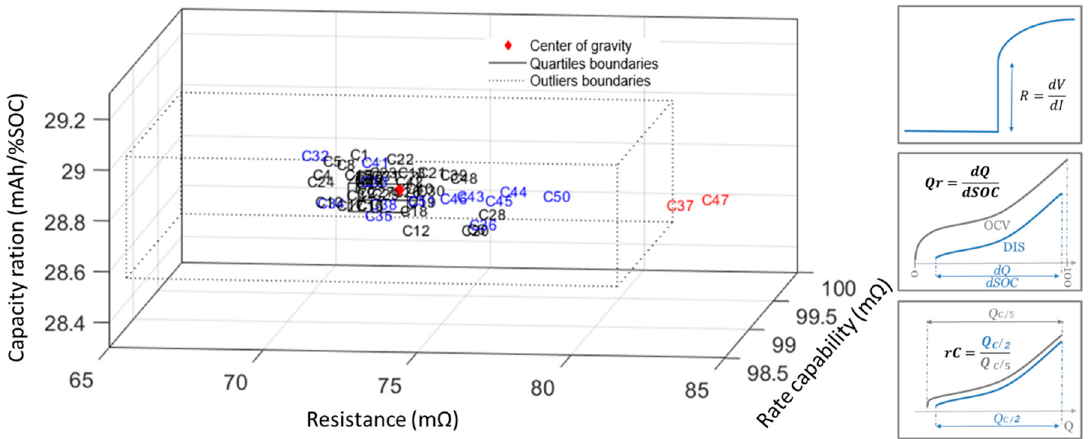
Figure 1. Summary of the cell-to-cell variations analysis presenting the combined variations in measured rate capability, capacity ration, and ohmic resistance. A graphical representation of each of the three metrics is shown on the right.